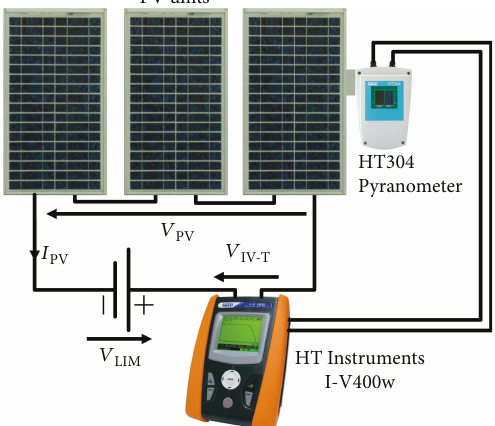
Figure 14: I - V characteristics of the three series-connected PVUs with a growing number of shaded cells. 27 September 2017, Aversa (CE), Italy. S 1 = 775W/m 2 characterizes the unshaded cells, and = 180 W/m 2 characterizes the shaded cells; T S 2